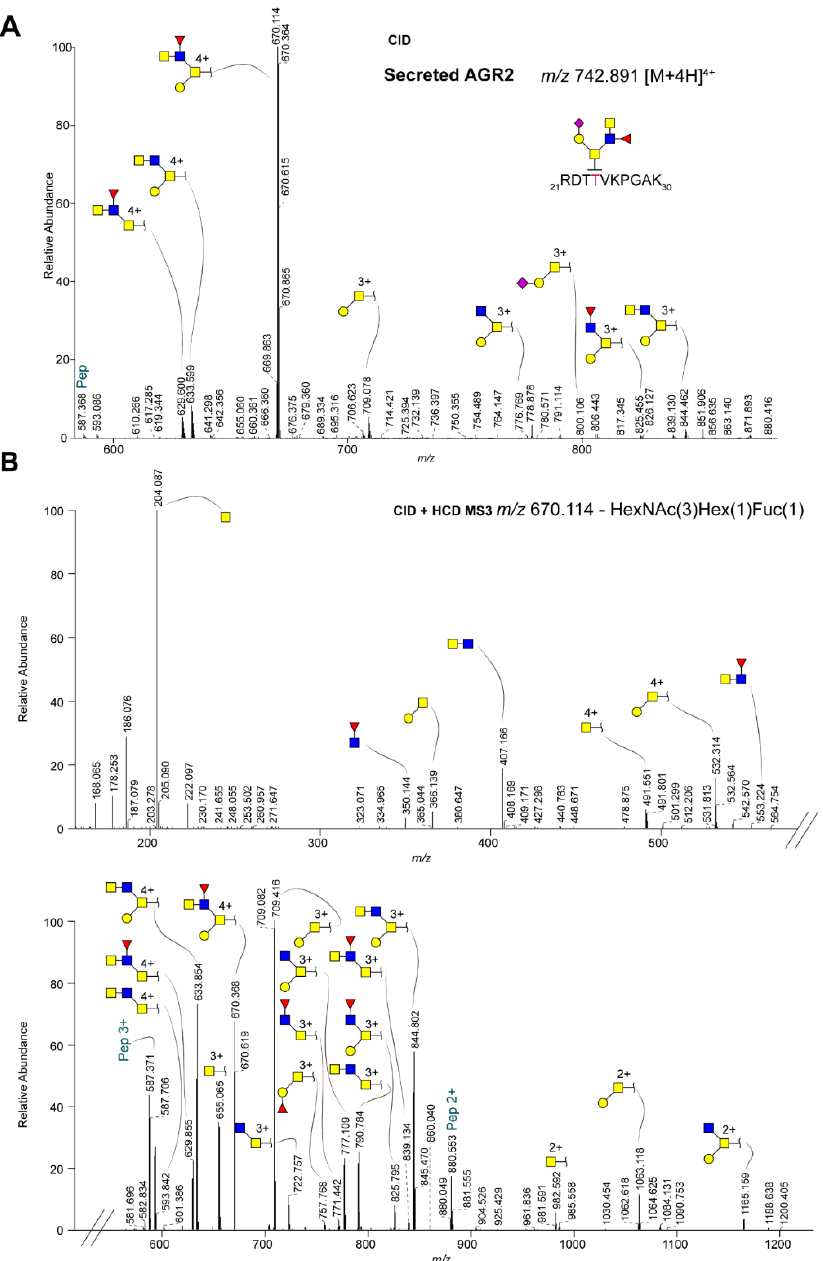
Figure 6. In-depth MS characterization of the glycan structure on secreted AGR2. ( A ) The TMT- labeled AGR2 tryptic O- glycopeptide from secreted AGR2 (see Figure 5B), was analyzed after CID fragmentation. The proposed glycan structure on secreted AGR2 is shown on the peptide sequence. ( B ) The ion representing the loss of the terminal sialic acid ( m / z 670.114) was subsequently selected for HCD fragmentation (upper and lower panel, representing different regions of the resulting MS/MS spectrum). The terminal end of the glycan structures indicates the TMT-labeled tryptic peptide RDTTVKPGAK from secreted AGR2. Blue square: GlcNAc; yellow square: GalNAc; yellow circle: galactose; red triangle: fucose; purple diamond: N- acetylneuraminic; Pep: peptide.